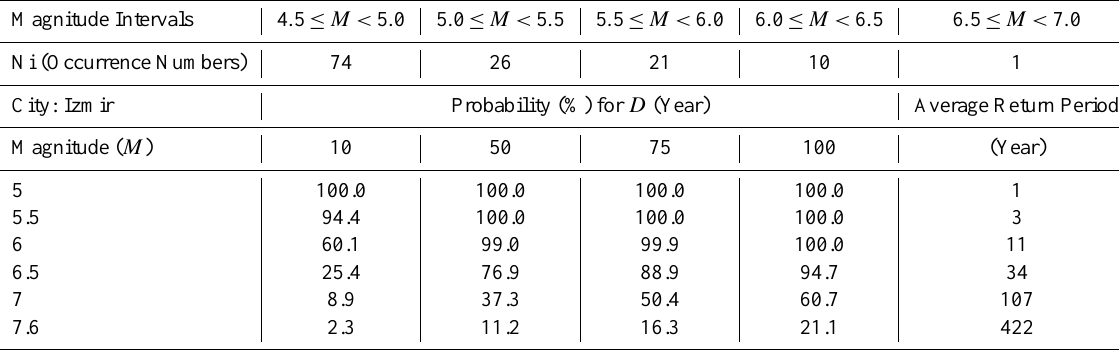
Table 3m. Earthquake occurrence probability (%) for D (Year) for zmir city. Magnitude Intervals